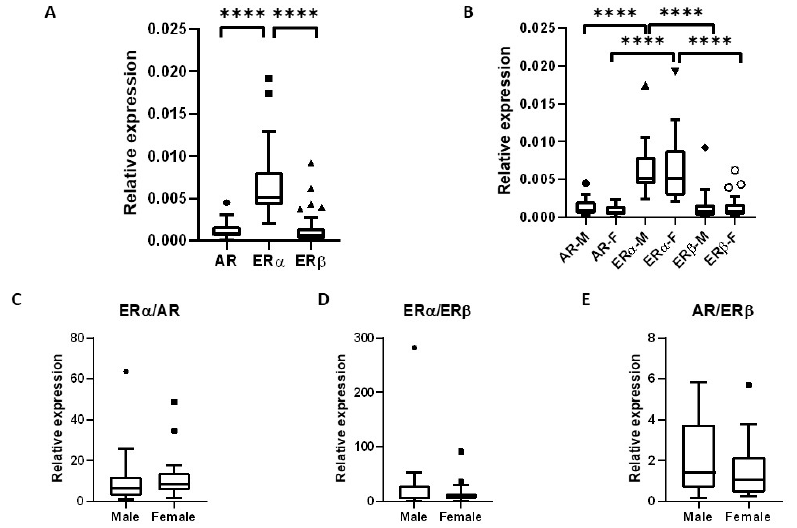
Figure 1. Sex steroid receptor mRNA expression in human lacrimal glands. ( A ) Box and whiskers plot that shows significantly higher ER α expression in comparison to AR and ER β expression, and no significant difference between AR and ER β expression in lacrimal gland samples. ( B ) Box and whiskers plot that shows no significant difference between male and female lacrimal glands in AR, ER α and ER β expression. ER α expression is significantly higher than AR and ER β expression in both male (M) and female (F) samples. ( C – E ) Box and whiskers plots that show no significant difference in ER α to AR, ER α to ER β , and AR to ER β expression ratios, respectively, between male and female lacrimal glands. **** p <0.0001.